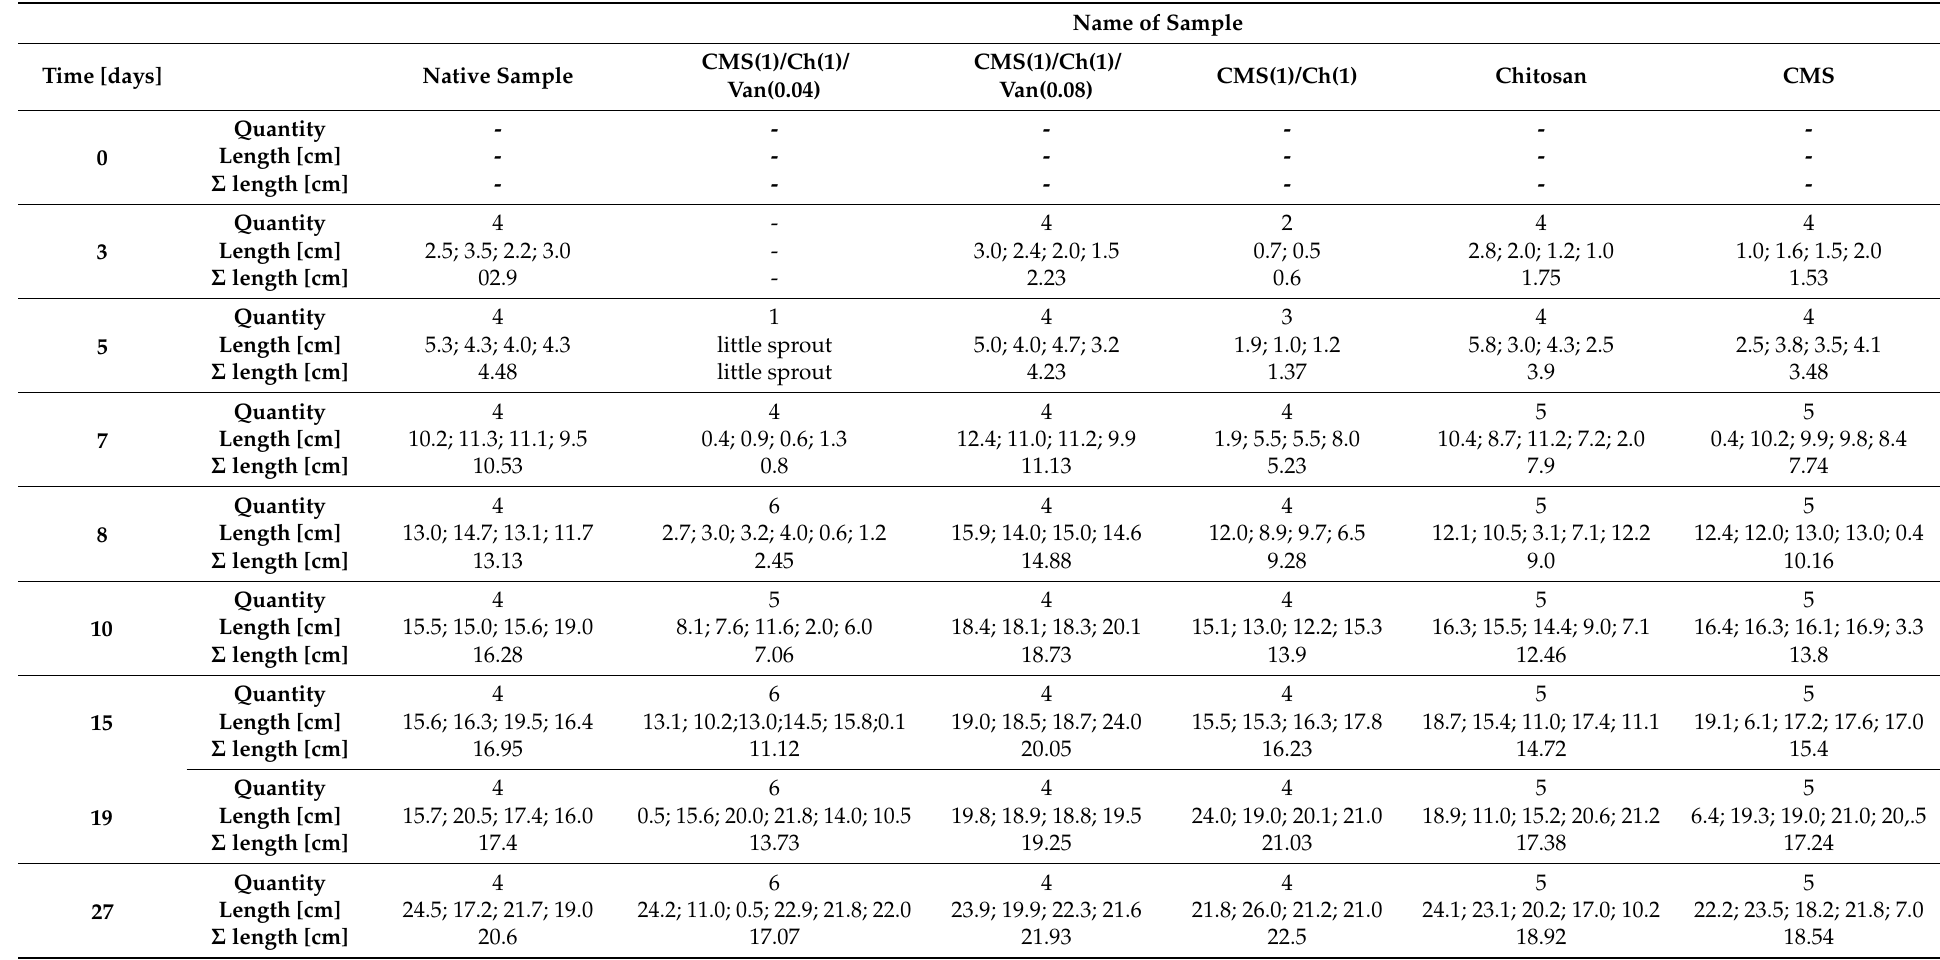
Table 10. Metric diagnosis including quantity and growth of the germinated plant.